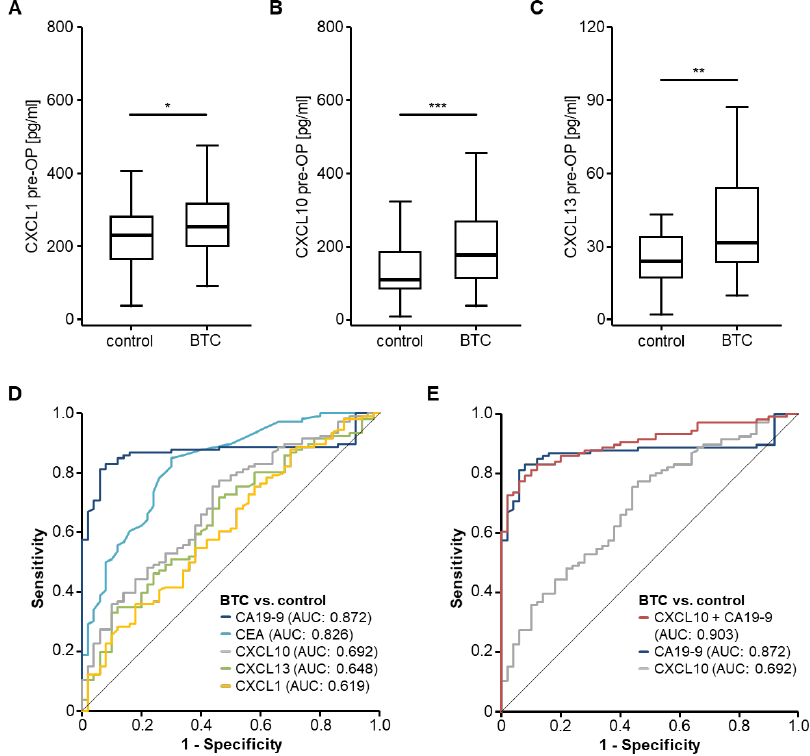
Figure 1. Circulating chemokine levels in biliary tract cancer patients. ( A – C ) BTC patients have significantly elevated serum levels of CXCL1, CXCL10 and CXCL13 compared to healthy controls. ( D ) Circulating chemokine levels show lower AUC values for the discrimination between BTC patients and healthy controls compared to established tumor markers such as CEA and CA19-9. ( E ) The combination of CXCL10 and CA19-9 further increases the AUC value for the identification of BTC cancer patients. * p < 0.05; ** p < 0.01; *** p <